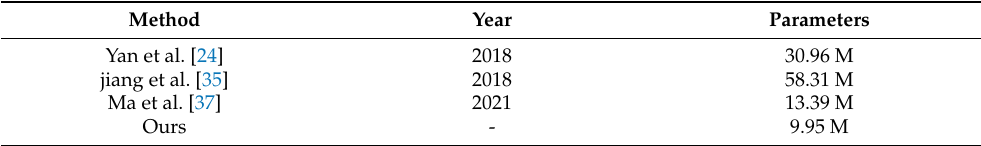
Table 9. The network parameters comparison of the proposed method with other methods based on